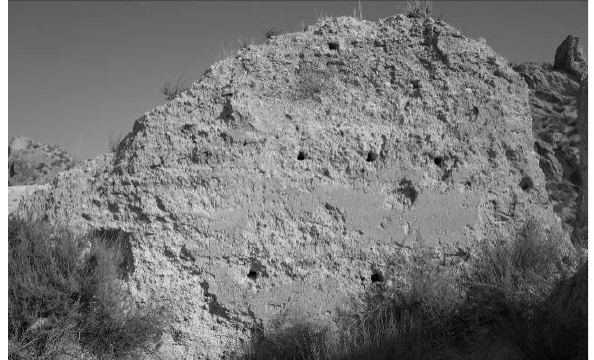
Figure 14. Tower I. Northern front built with (TT1).